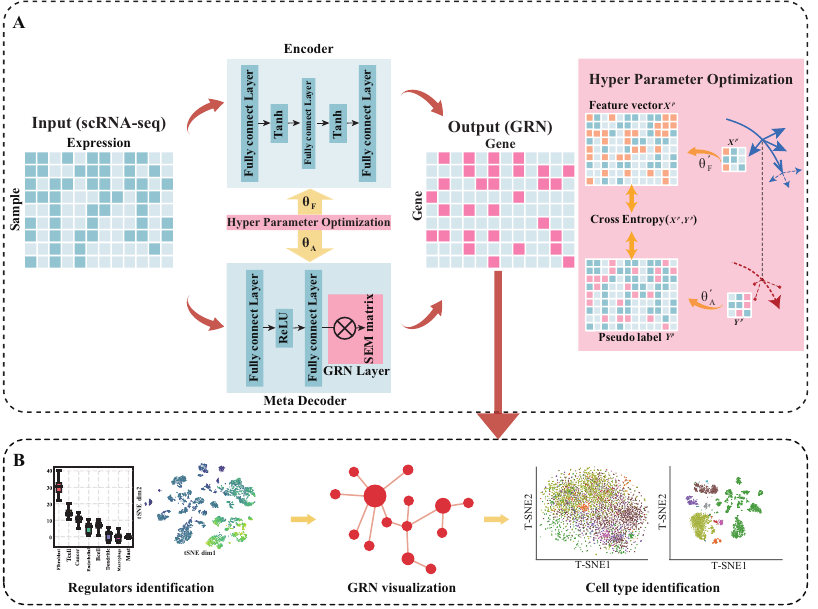
Figure 1. ( A ) The overview of MetaSEM: the meta-decoder extracts the regulatory relationship to output a pseudo-data label. The encoder transforms the data feature into feature vectors. The GRN Layer is a specially designed layer for embedding the SEM matrix. The red arrows indicate the outer loop, and the yellow arrows indicate the inner loop. With hyperparameter optimization, MetaSEM integrates the outer and inner loop based on gradient. The θ F represents the hyperparameters of the encoder, and θ A represents the hyperparameters of the meta-decoder. ( B ) By analyzing the SEM matrix, MetaSEM performs three major functions: identification of the regulators, GRN visualization, and cell-type